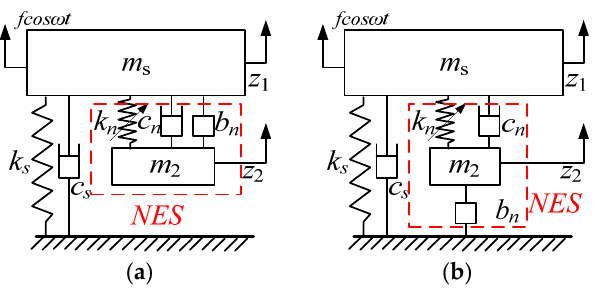
Figure 1. Two vibration models of the SDOF system coupled with NES: ( a ) (S.1); ( b ) (S.2). Therefore, the dynamic models of the two schemes can be obtained from Newton’s second law, as shown in Equations (2) and (3).